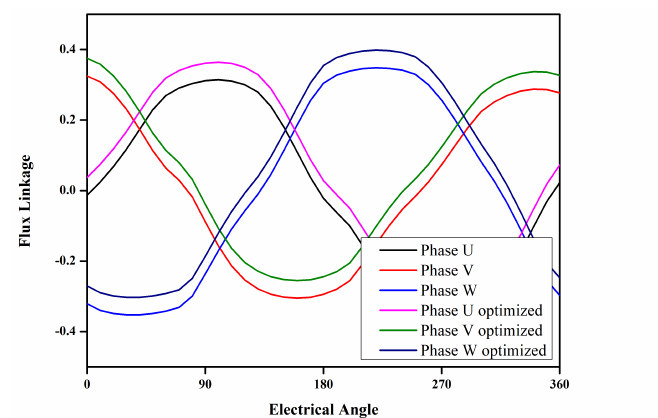
Figure 9. Flux linkage before and after optimization.